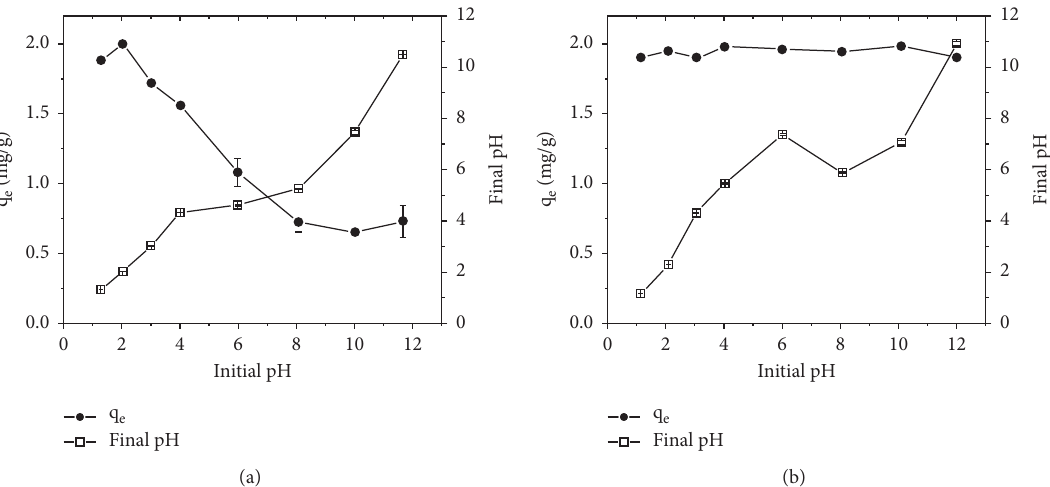
Figure 8: Effect of pH on the absorption of Cr(VI) onto TR (a) and PSS (b) (initial concentration of Cr(VI) 5mg/L, shaking speed 200rpm, adsorbent dose 2.5 g/L, and temperature 25 °